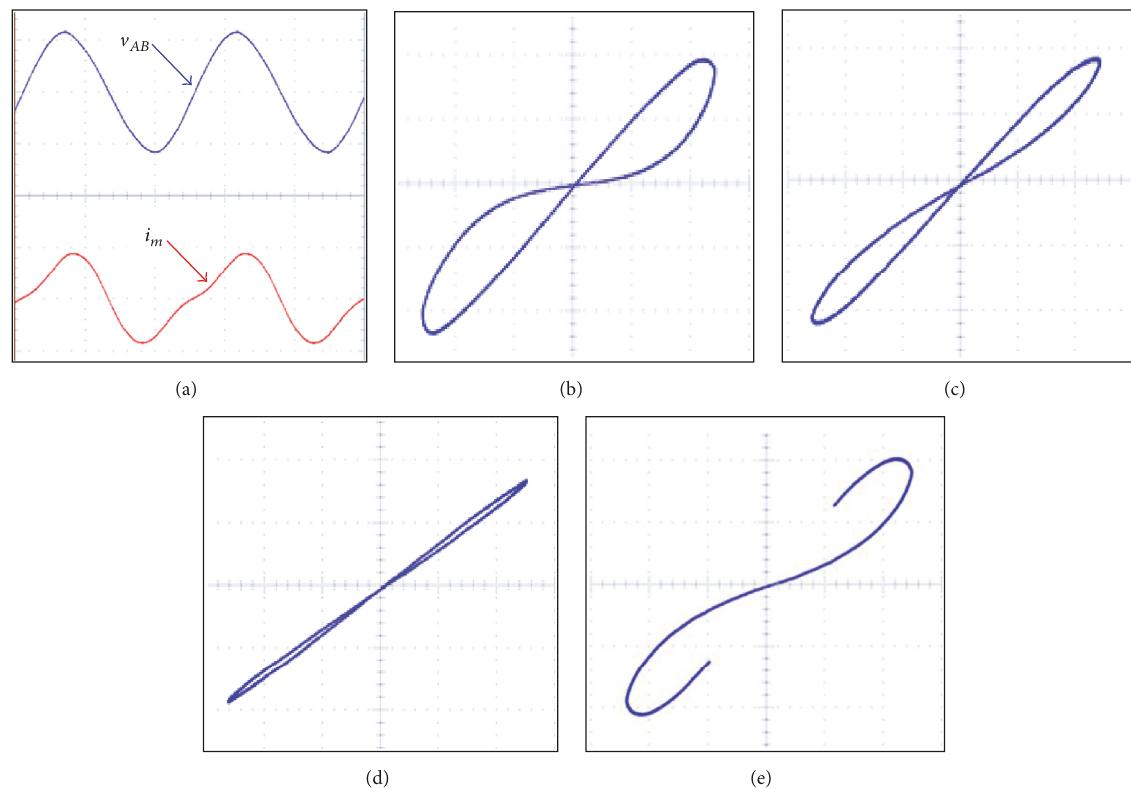
Figure 6: Experimental results of the incremental type emulator when 𝐶 1 = 𝐶 2 = 100 nF. (a) waveforms of the input voltage V 𝐴𝐵 and input current 𝑖 𝑀 in the time domain; (b), (c), (d), and (e) represent hysteresis loops in V - 𝑖 plane operating at 10 Hz, 50 Hz, 100Hz, and 7Hz, respectively. The time scale is 40ms/div, and scales are 0.2V/div for 𝑥 -axis and 0.2 V/div for 𝑦 -axis.